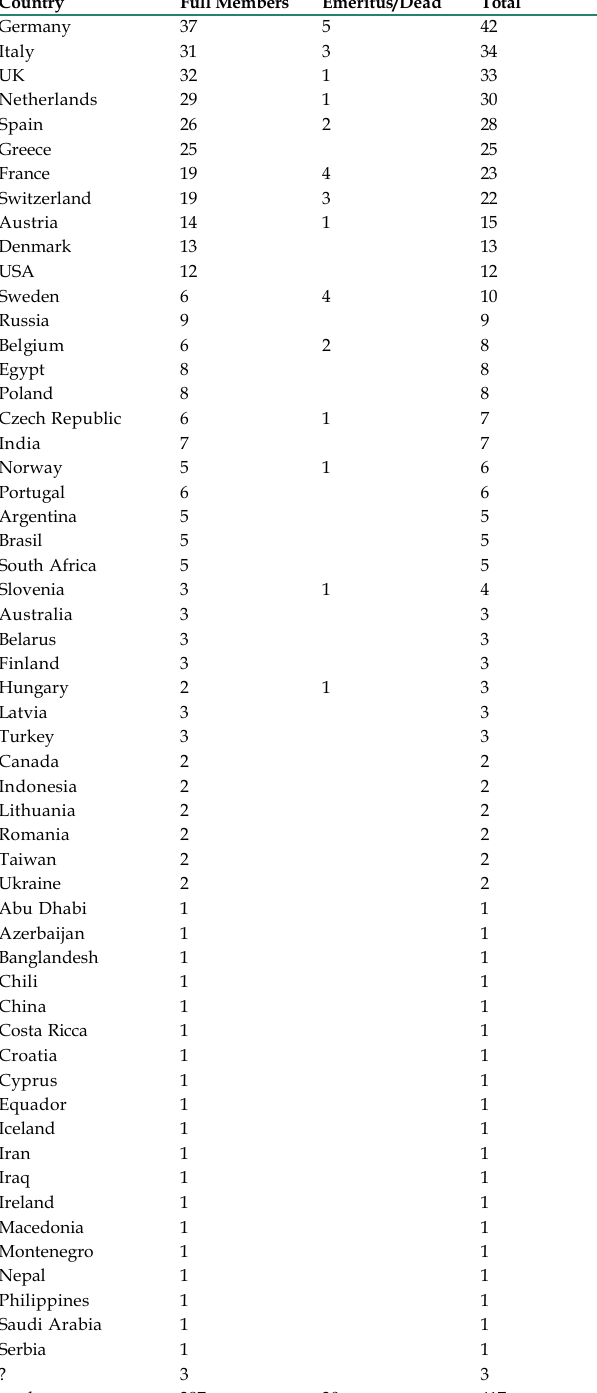
Table 4. Origin of all members of EBJIS in 2017